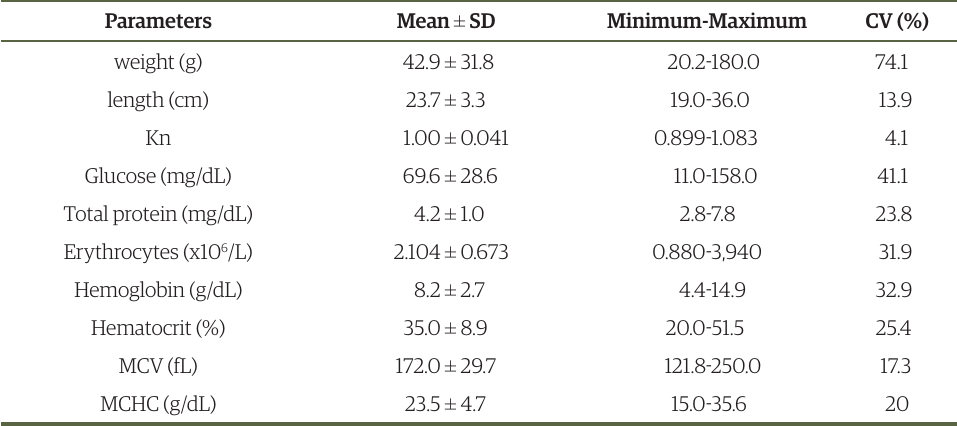
Table 1. Mean values ± standard deviation (SD), variation, and coefficient of variation (CV) of the